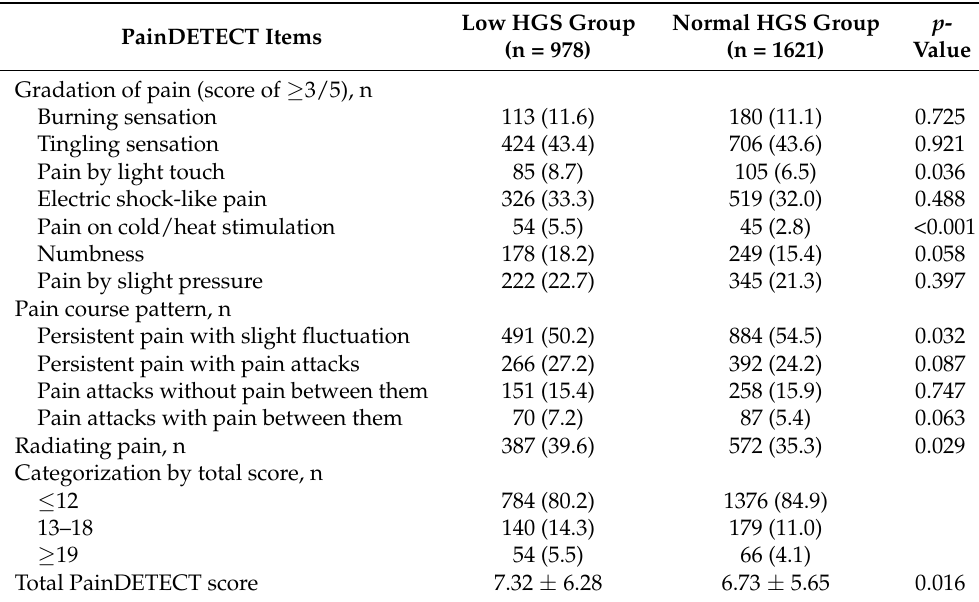
Table 4. Comparison of the results of the painDETECT items between patients with low and nor- mal HGS